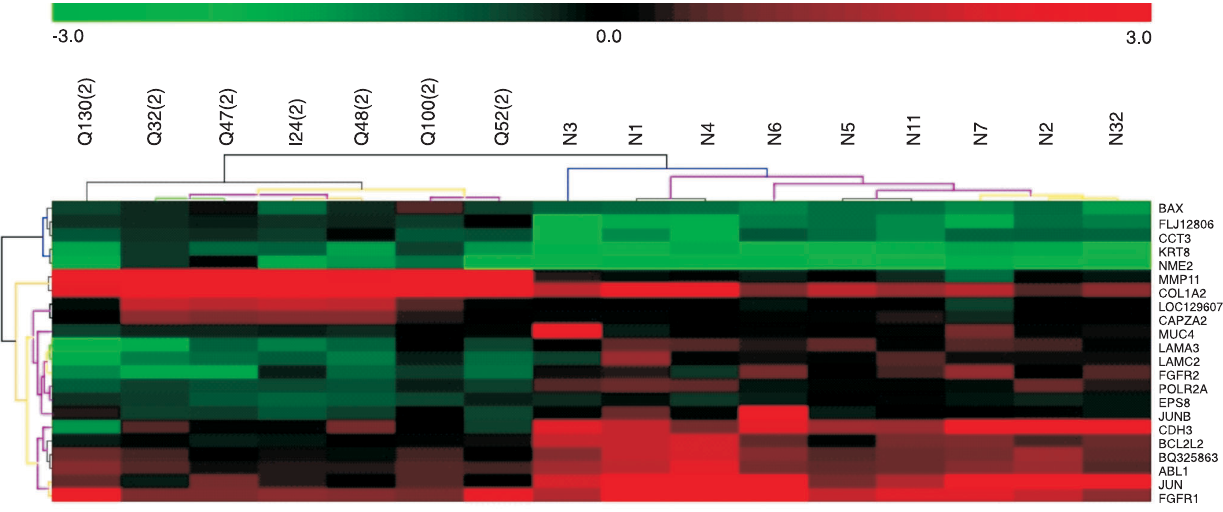
Figure 1. Unsupervised hierarchical clustering of 7 clinical stage II breast cancer samples and 9 normal breast samples (N) based on 22 differentially expressed genes at a false discovery ratio level of 0.05. Tumor identification (beginning with I, Q) appears at the top of the figure and each column represents gene expression of a single tumor. UniGene cluster ID or gene ID or ORESTES is shown in each row. The upper colored bar indicates the variation in gene expression in target samples as compared to reference cells (HB4A), i.e., red, more expressed and green, less expressed in target samples. The colored lines of the dendrogram stand for the support for each clustering, black and gray meaning more reliable and yellow and red less reliable. The metric used was Euclidean distance, with complete linkage for distance between